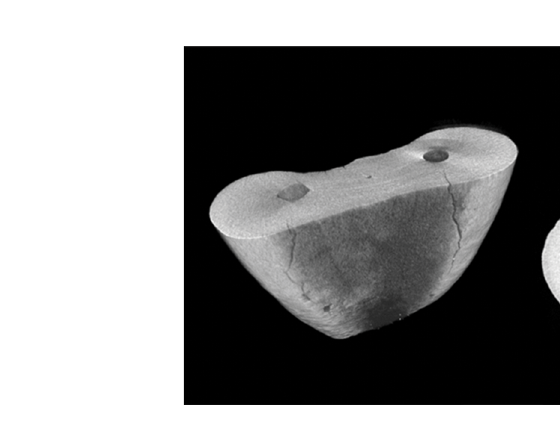
Figure 1. 3D reconstructions showing microcracks in the mesial roots of mandibular